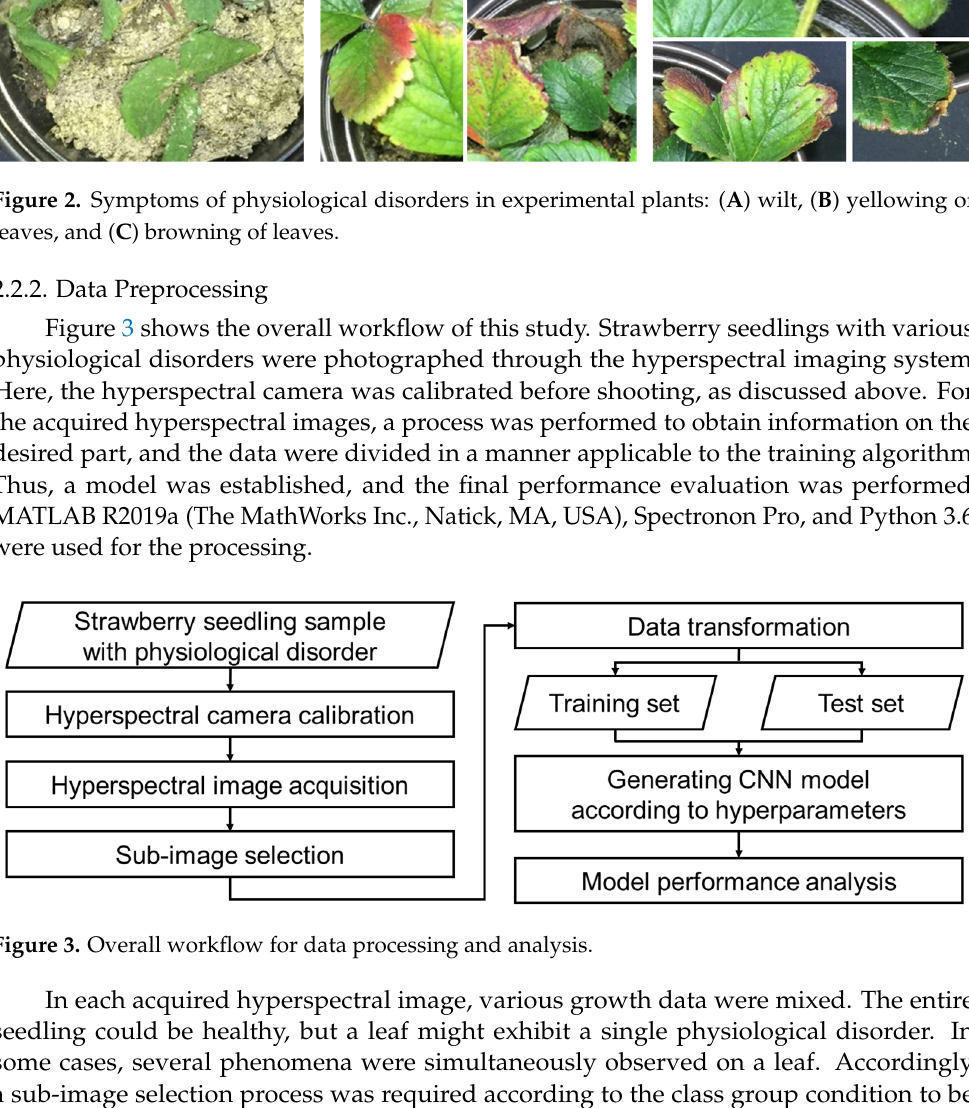
Figure 4. Example of obtaining subimages corresponding to each class from hyperspectral images of leaves. A relatively large amount of training data is required for deep learning analysis, which is the algorithm employed herein. Accordingly, a large number of subimages were acquired, and the number of data acquired for the seven classes is shown in Table 1. A class number was assigned to each physiological disorder class, and the data were ran- domly divided and used with a ratio of 9:1 for training and testing. To avoid overfitting problems and consider variance, the training data were randomly mixed while creating the model and then divided into training and validation data. Subsequently, the total data were divided with a ratio of 7:2:1 for training, validation, and testing.